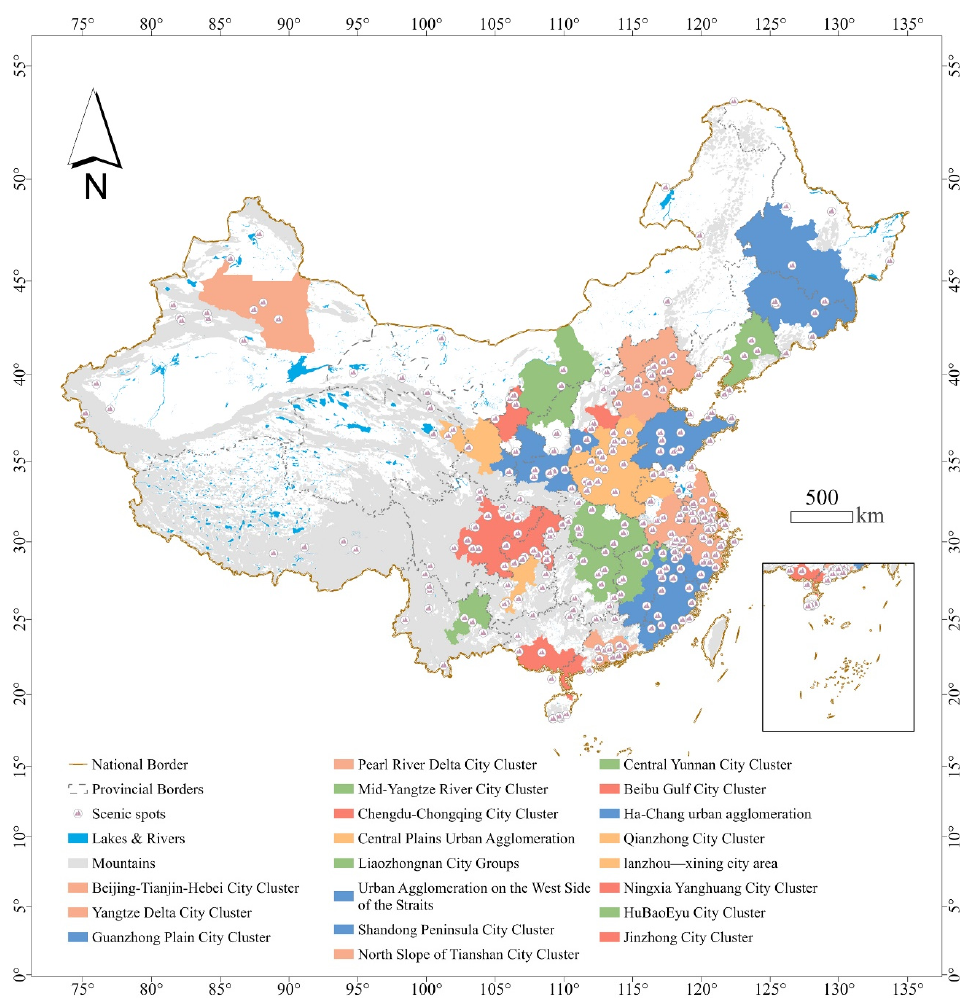
Figure 1. Distribution of 5A scenic areas in